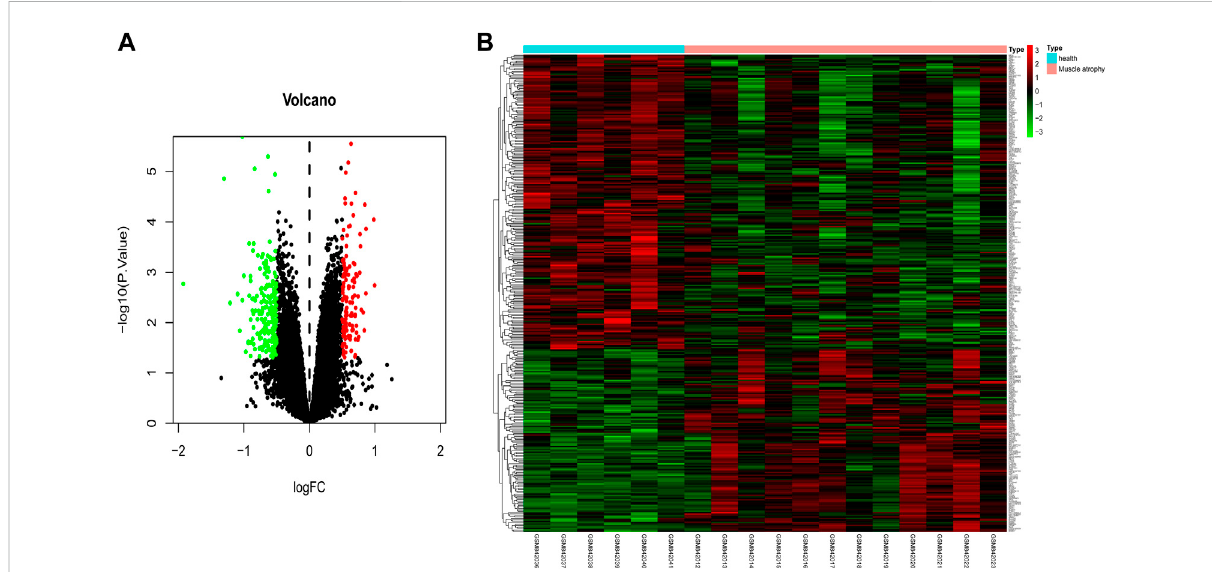
FIGURE 4 Identi fi cationofdifferentiallyexpressedmRNAsinmuscularatrophy.Identi fi cationofDEmRNAsinmusclesamplesfrompatientswithmuscular dystrophy and healthy individuals. (A) Volcano map of genome-wide DE mRNAs. (B) Heatmap showing all of the upregulated and downregulated mRNAs screened. Green and red represent downregulated and upregulated mRNAs, respectively.